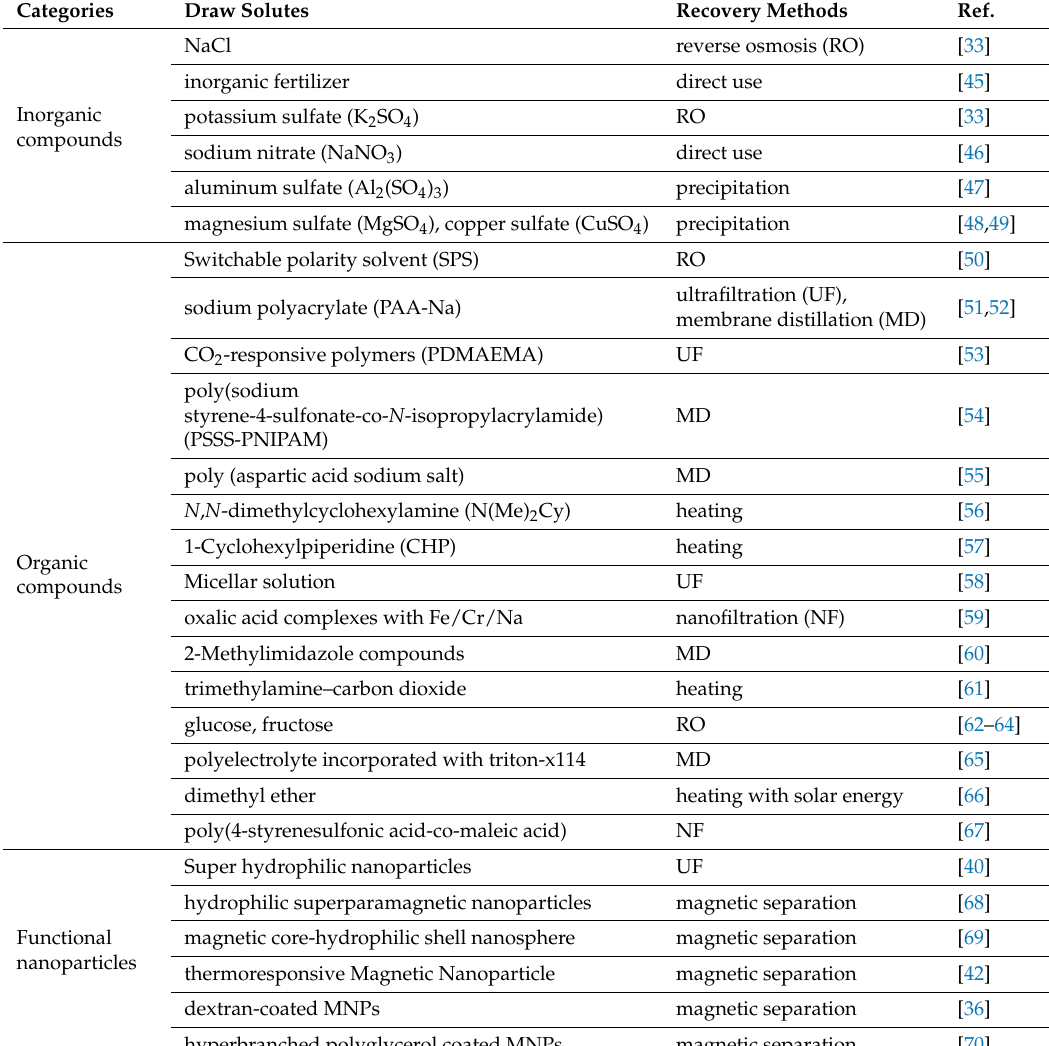
Table 1. Overview of the traditional classification of draw solutions (DSs) in forward osmosis (FO)